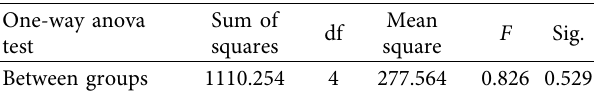
Table 2: P value was found to be more than 0.005, indicating a nonsignificant difference. P >